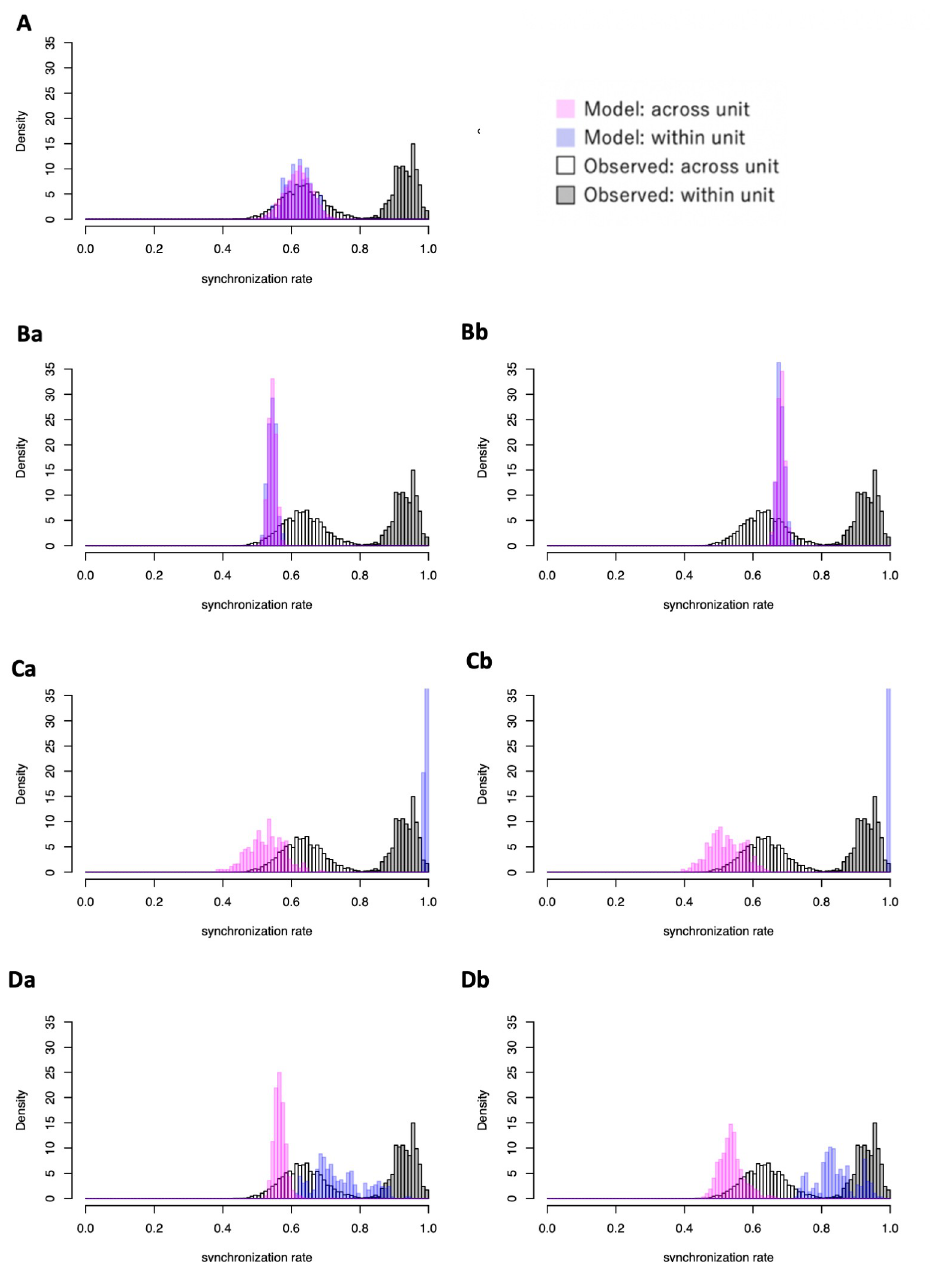
Fig 7. Histograms of the synchronization rate. White and grey bars represent the observed value of synchronization rate across units and within units, respectively. Pink and blue bars represent those of the simulated data across units and within units, respectively. The name of the models is same as in Fig